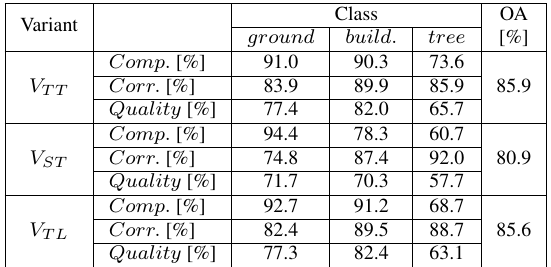
Table 1: Overall accuracy ( OA ), completeness ( Comp: ), correct- ness ( Corr: ) and quality values for the classes ground ,